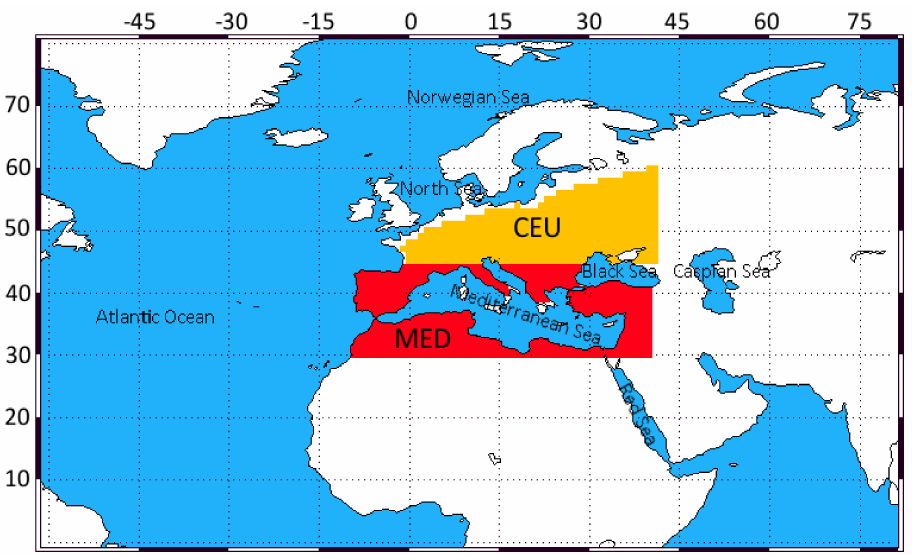
Figure 1. Central European (CEU) and Mediterranean (MED) regions. The respective boundaries were defined in the 5th Assessment Report (AR5) of the Intergovernmental Panel on Climate Change